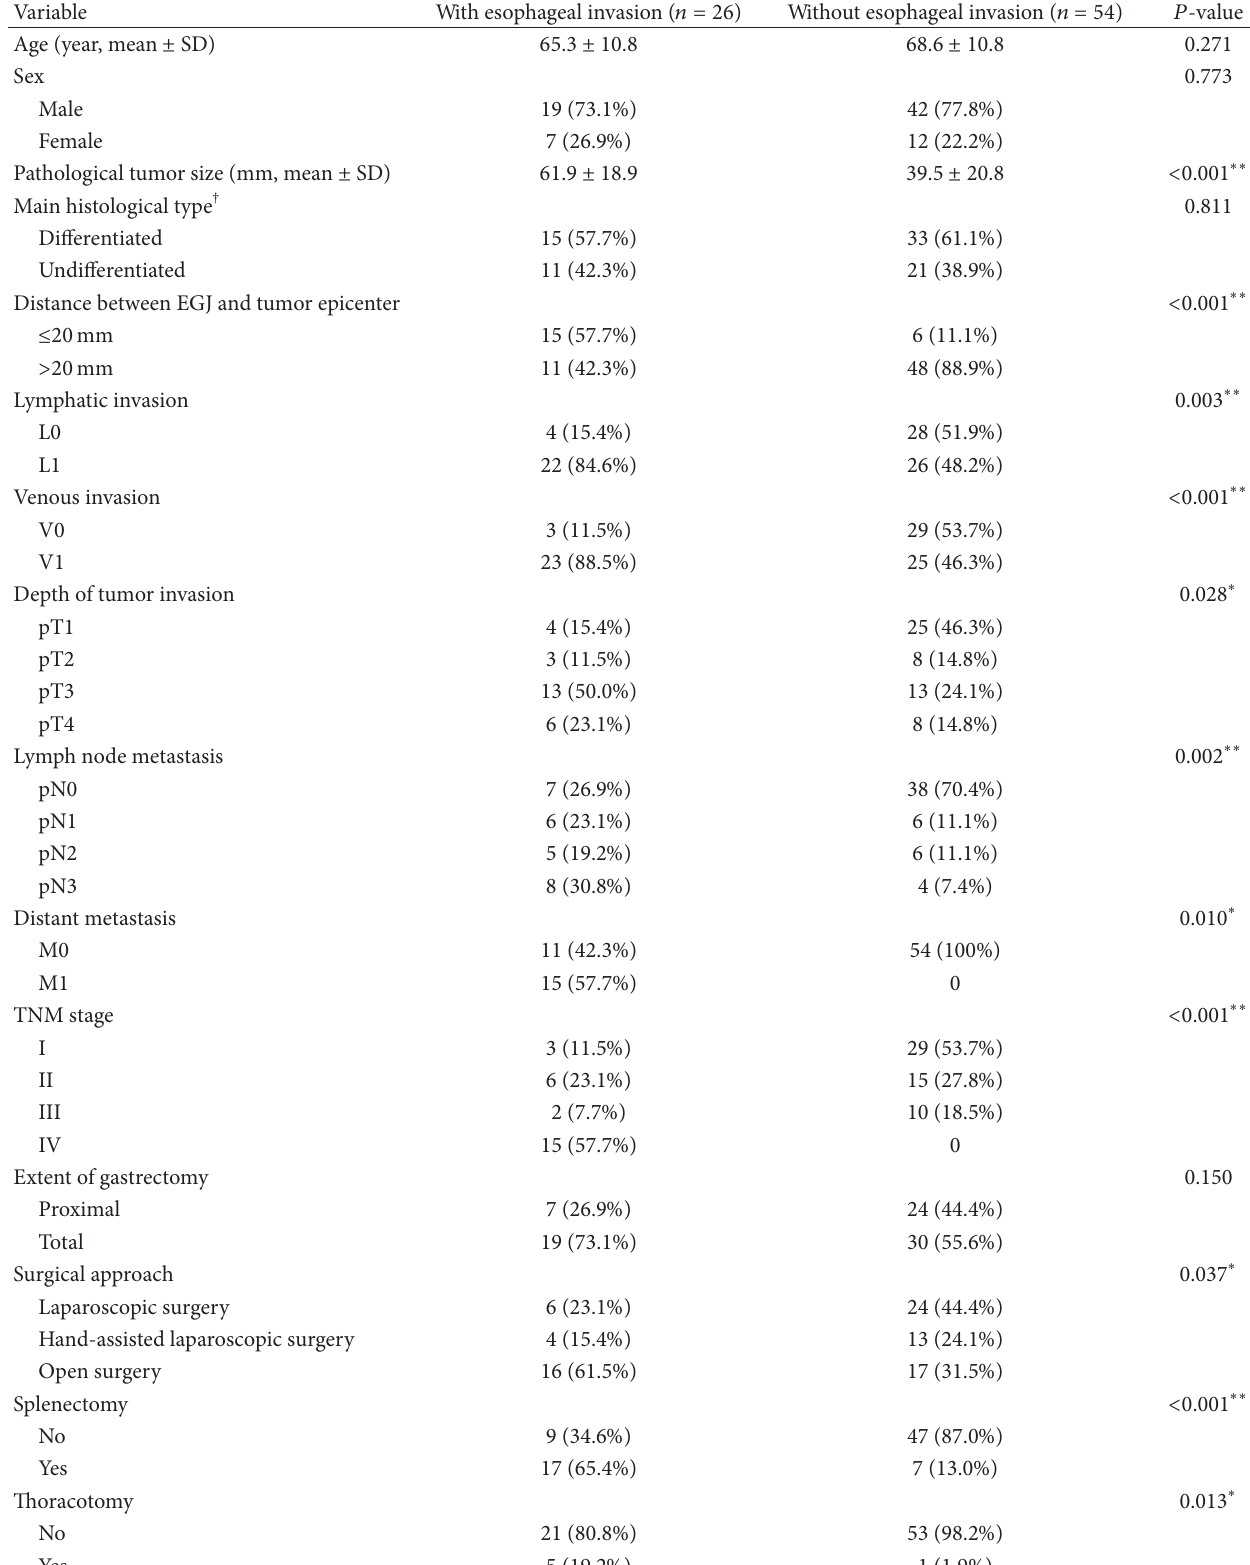
T 2: Comparison of clinicopathological characteristics of patients with gastric cardia cancer with or without esophageal